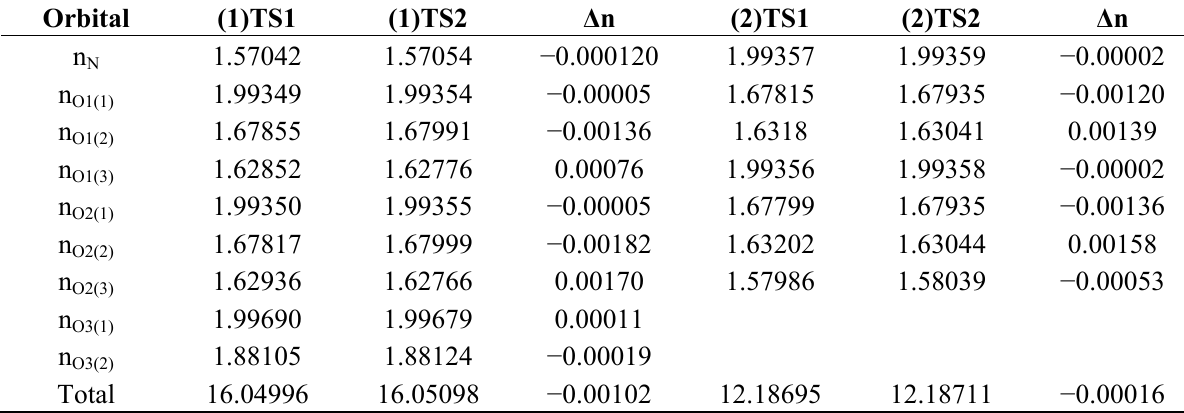
Table 6. Occupancies ( e ) of lone pairs in the transition states according to NBO analyses a–c